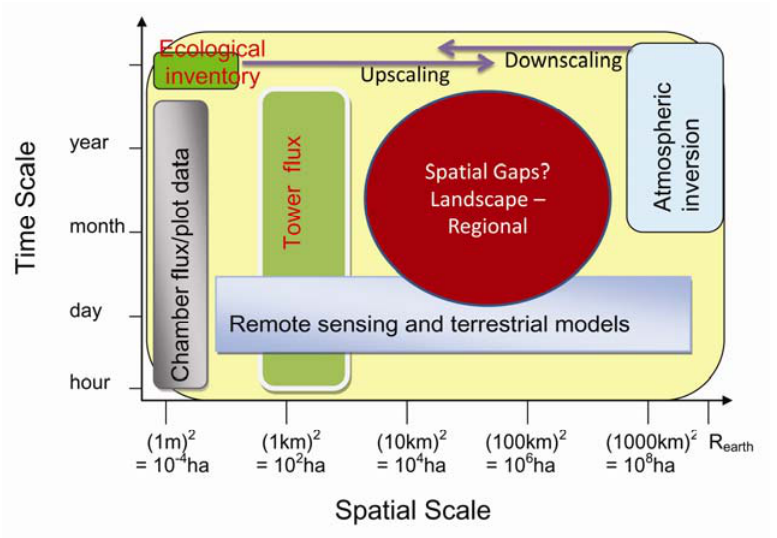
Figure 3. Temporal and spatial scales of different